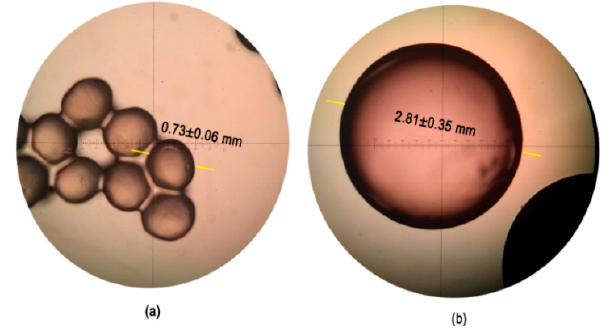
Figure 3. ( a ) Optical microscopy of the alginate microcapsules with L. sphaericus CBAM5 (average diameter is 0.73 ± 0.06 mm). ( b ) Optical microscopy of the dripped alginate capsules with L. sphaericus CBAM5 (average diameter is 2.81 ± 0.35 mm) [17].